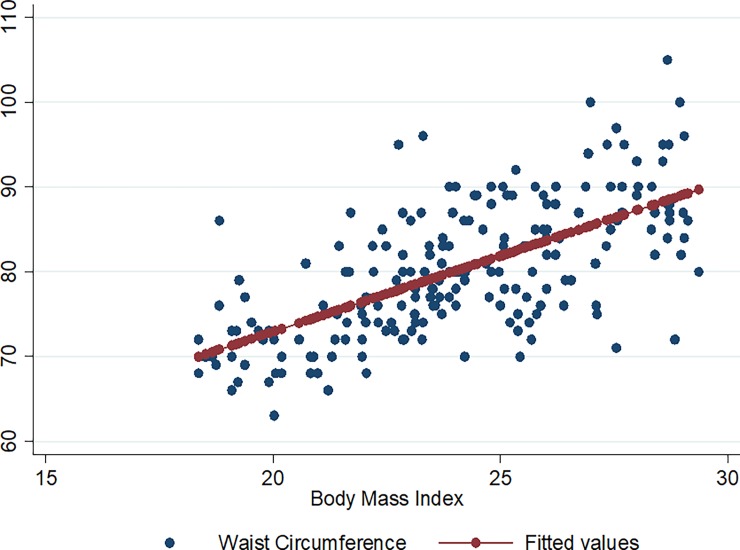
Linear regression model of the association between WC and BMI in all study participants.